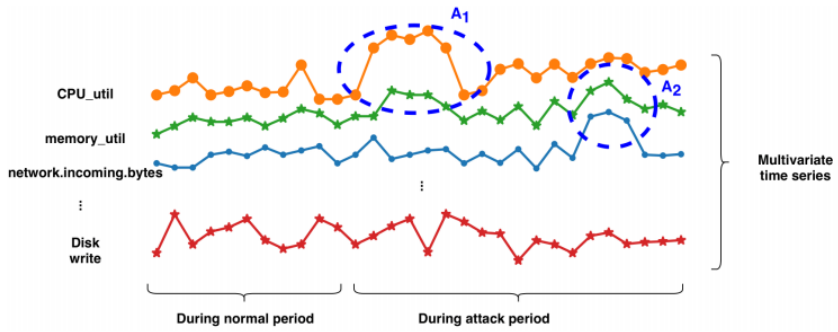
Figure 3. Suspected regions occurring during normal and EDoS attacks